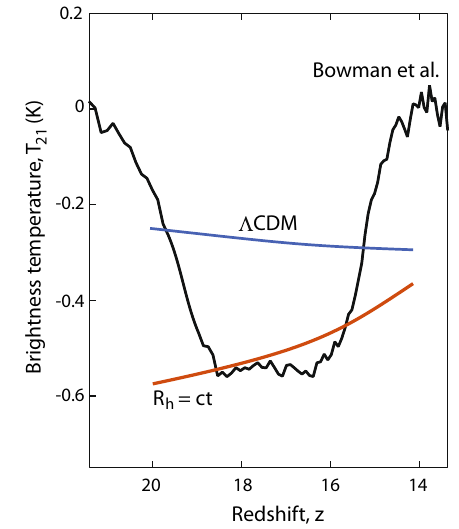
Fig. 1 Best-fitting21-cmabsorptionprofile(solidblack)forthebright- ness temperature T 21 corresponding to the hardware and analysis con- figuration with the highest signal-to-noise ratio (equal to 52), versus redshift, reported by Bowman et al. [1], compared with the predicted brightness temperature in the (cid:2) CDM (solid blue) and R h = ct (solid red)